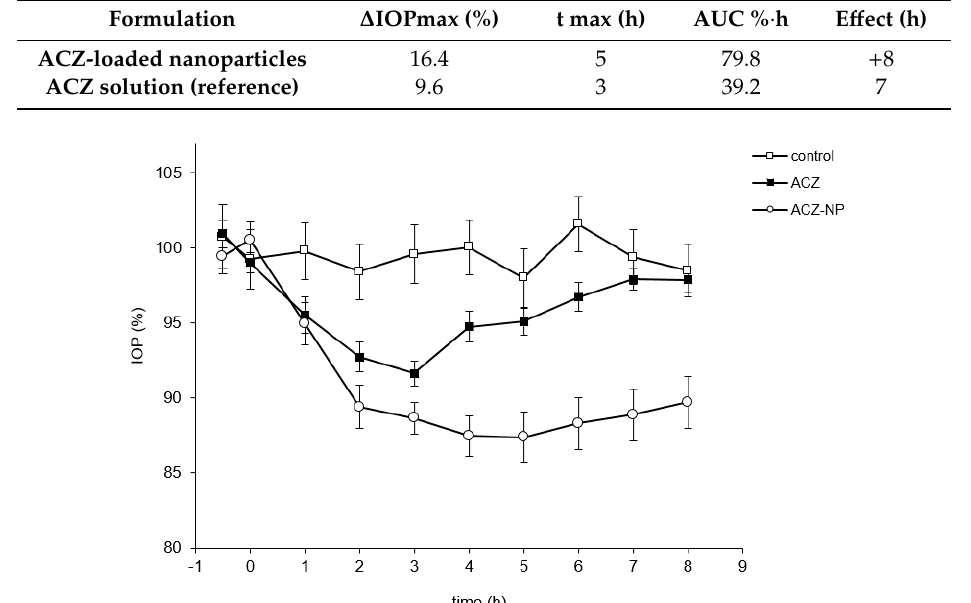
Figure 8. Ocular hypotensive effect of ACZ formulations. PBS was used as control. A solution of ACZ in PBS was employed as reference. Data are expressed as the mean ± SEM ( n = 20).